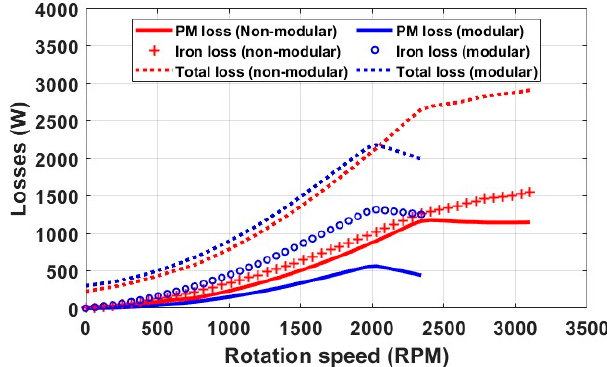
Figure 4. Losses-speed curves for the modular and non-modular machines operating at room temperature (20 ◦